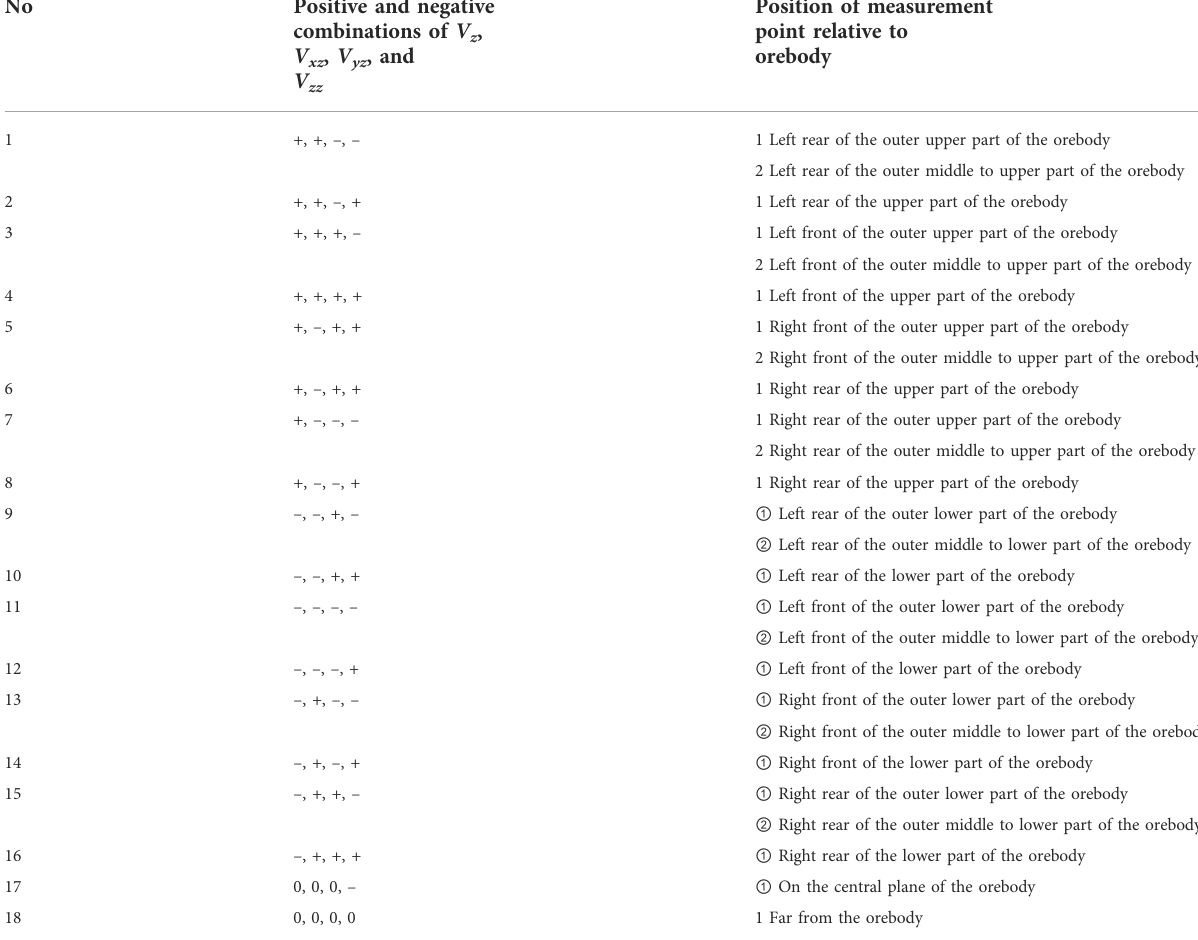
TABLE 2 Correspondence between the four parameters of the vertical high-density cuboid orebodies and the relative positions of the orebodies.